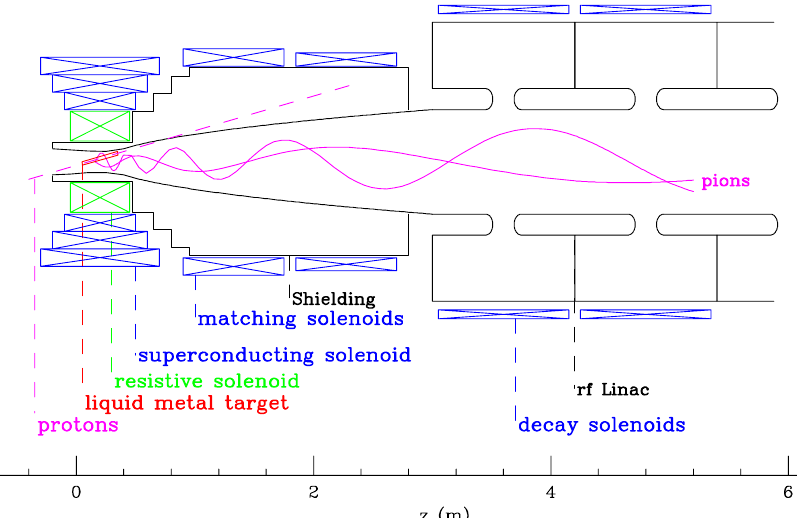
FIG. 14. (Color) Schematic view of pion production, capture, and initial phase rotation. A pulse of 16–30 GeV protons is incident on a skewed target inside a high-field solenoid magnet followed by a decay and phase rotation channel.